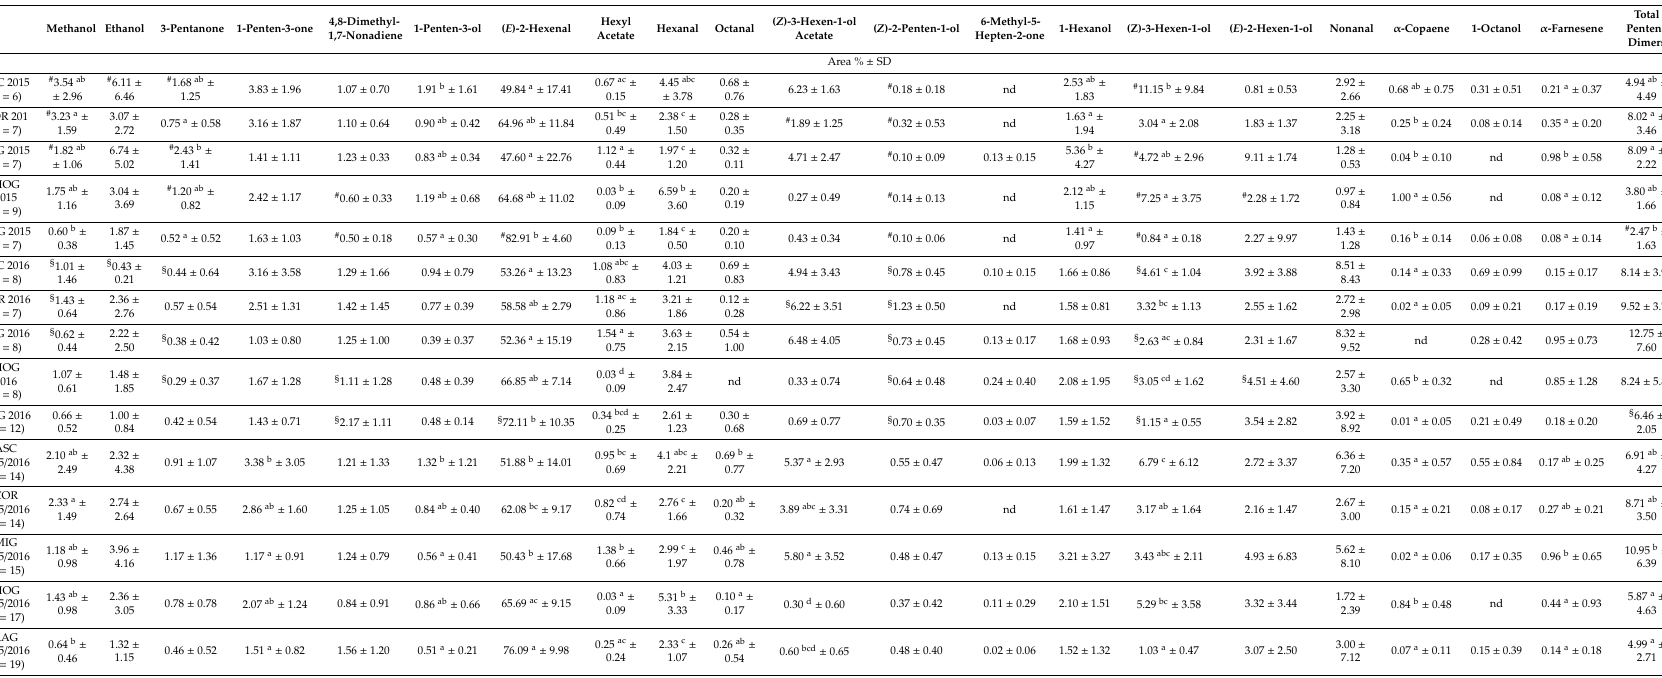
Table 2. Average percent composition in terms of peak area percentage ± standard deviation (SD) of selected volatile compounds analysed by head-space solid-phase microextraction and gas chromatography coupled to mass spectrometry, in the investigated monovarietal oils (ASC: Ascolana tenera, COR: Coroncina, MIG: Mignola, MOG: Piantone di Mogliano, RAG: Raggia) produced in 2015 and 2016 and in the total 2015 / 2016